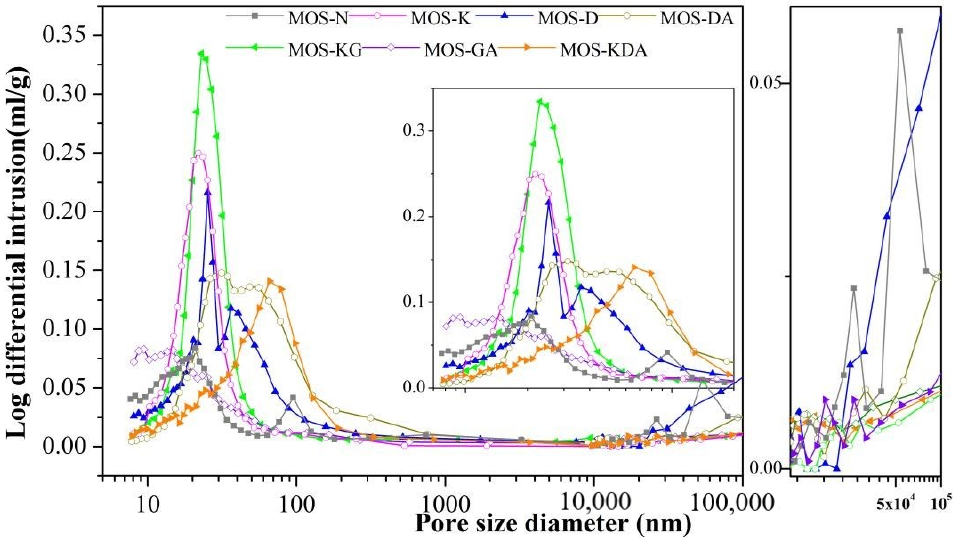
Figure 8. Pore size distribution for samples under different modifiers.